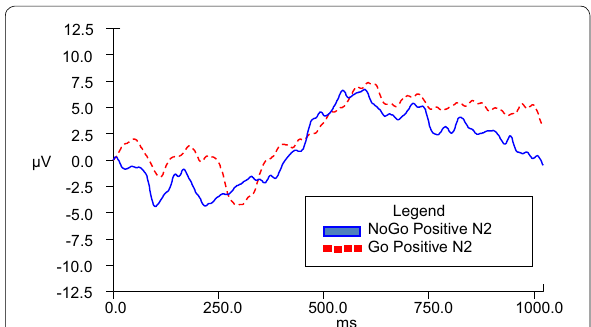
Fig. 7 Go and NoGo N2 ERP grand averages for 910-ms positive